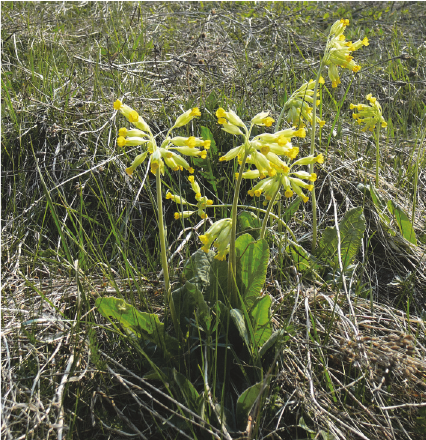
Figure 1: Cowslip (Primula veris) .